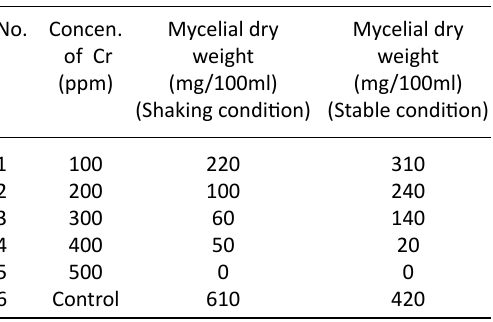
Table 4. Growth of A. terreus in Herbicide (pretilachlor) amended medium in Shaking and stable culture